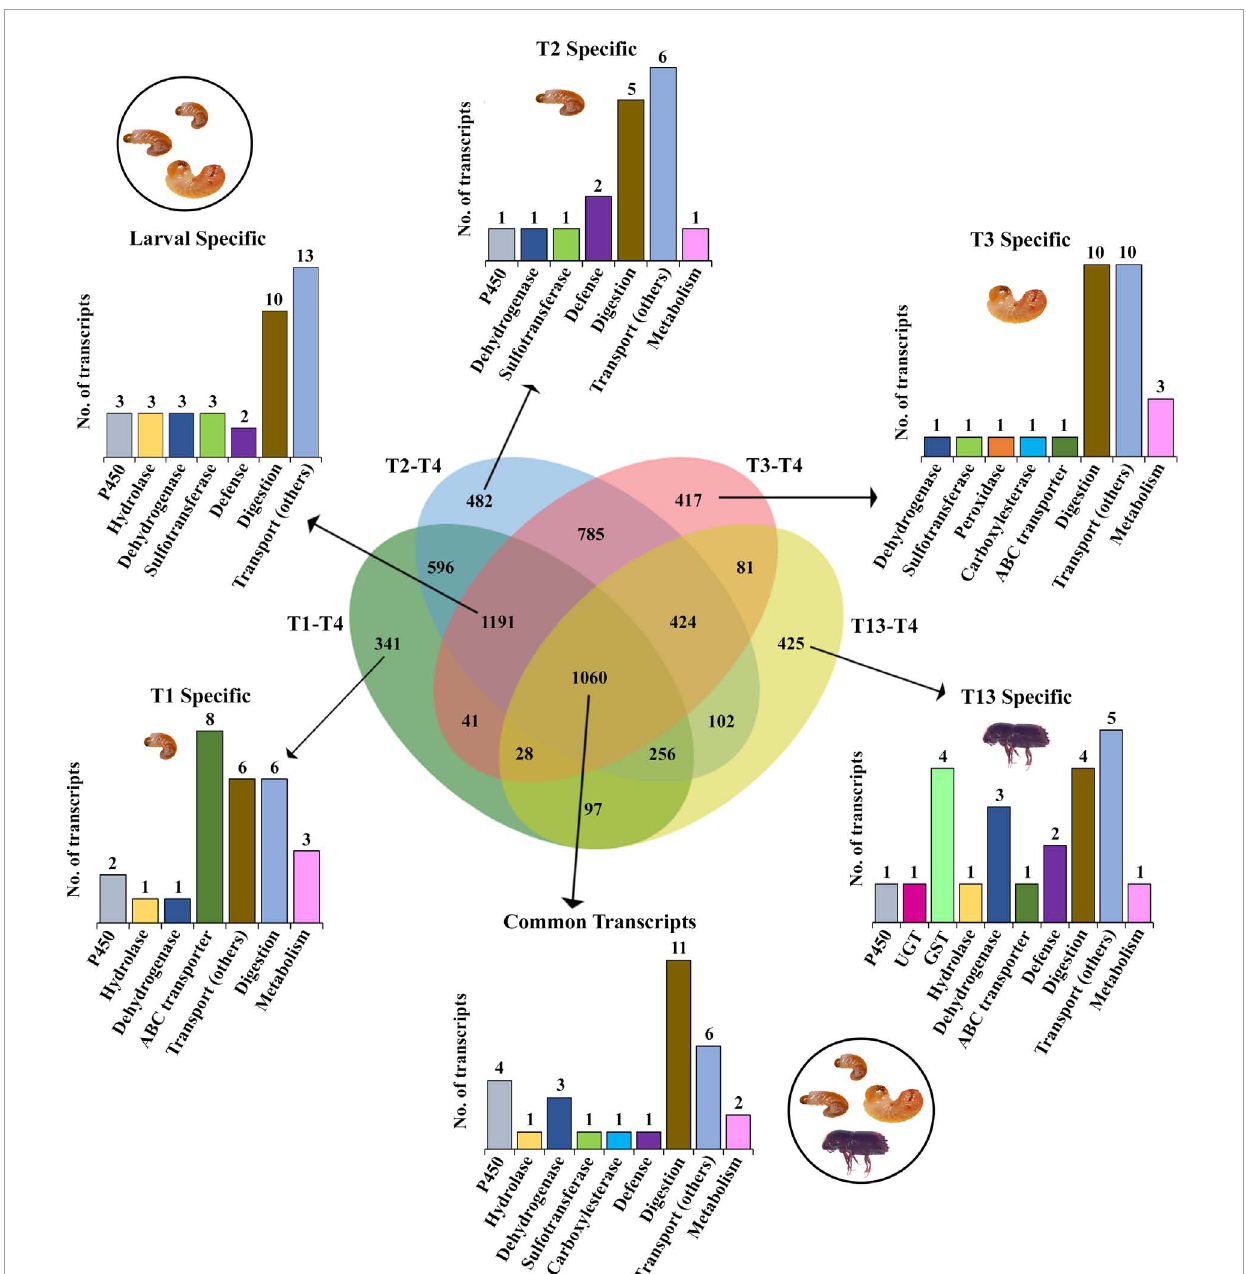
FIGURE6 Venn diagram representation of feeding vs. non-feeding stage comparison for downregulated enzymes deploying FDR p < 0.05 and fold change ≤ –2 the threshold for significance. Numbers within the Venn diagram represent the number of contigs found for each group. The bar graph corresponds to the number of contigs for each gene family identified from the list ( Supplementary material 37